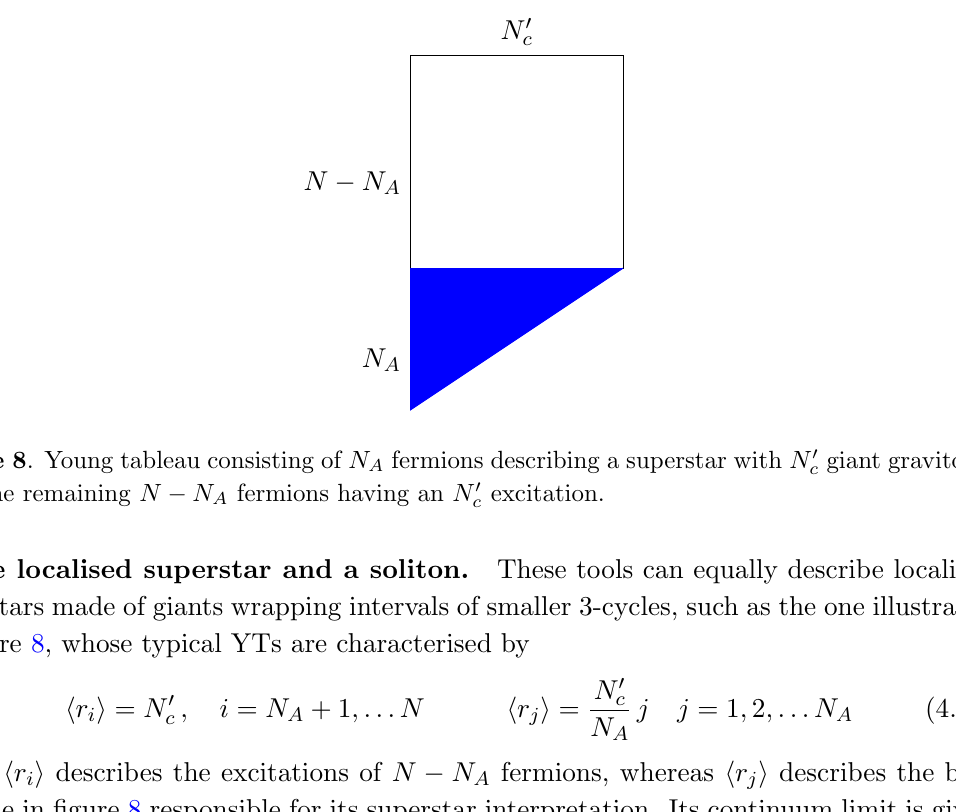
Figure 7 . Phase space density corresponding to a Fermi sea of N 1 fermions, followed by a localised superstar.